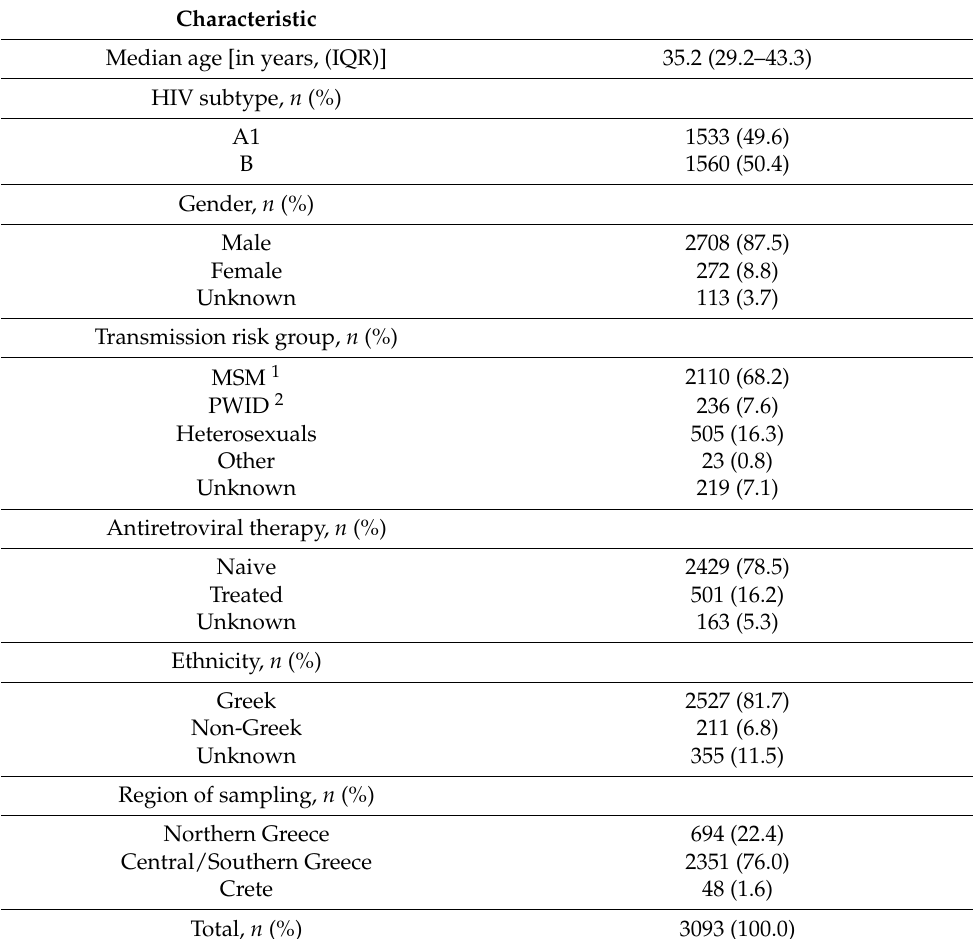
Table 1. Demographic characteristics of a subset of the study population (i.e., PLHIV infected within major molecular transmission